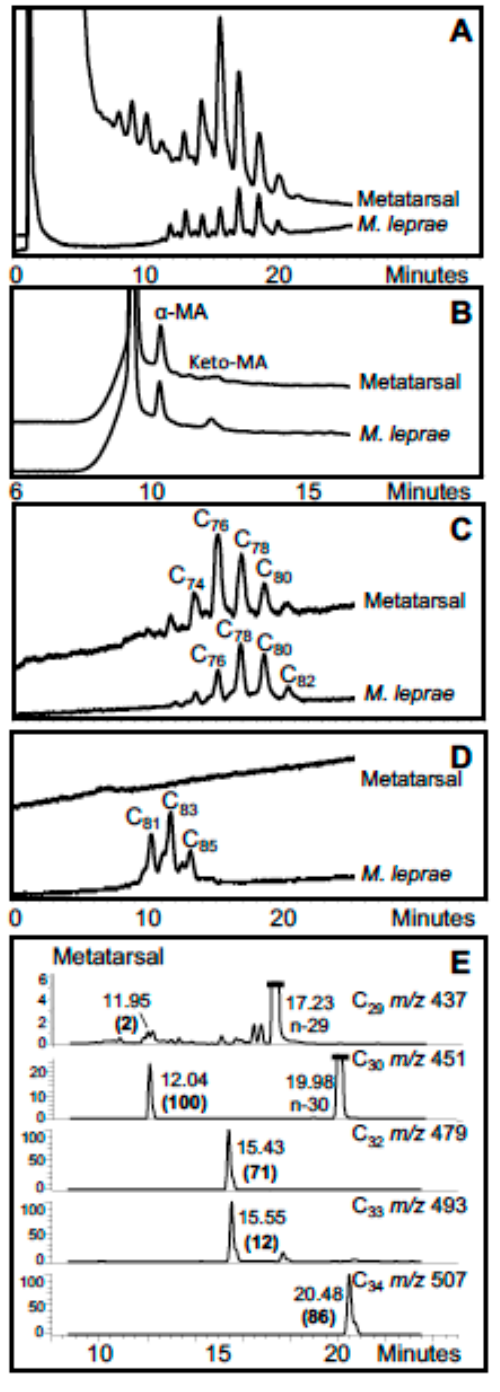
Figure 7. Lipid biomarker profiles for metatarsal from Great Chesterford leprosy specimen GC 96 [40]. ( A ) Total mycolates, reverse phase HPLC; ( B ) Collected total mycolates (MAs), normal phase; ( C ) Collected α -mycolates, reverse phase; ( D ) Collected ketomycolates, reverse phase; ( E ) GC-MS of mycocerosates (C 29 , C 30 , C 32 , C 33 , C 34 ) characteristic of leprosy. Comments: Inconclusive degraded MA profile has α -mycolates four carbons shorter than M. leprae, but good mycocerosate profile has M. leprae -specific C 34 mycocerosate. Verdict: Most likely leprosy and not MTB.